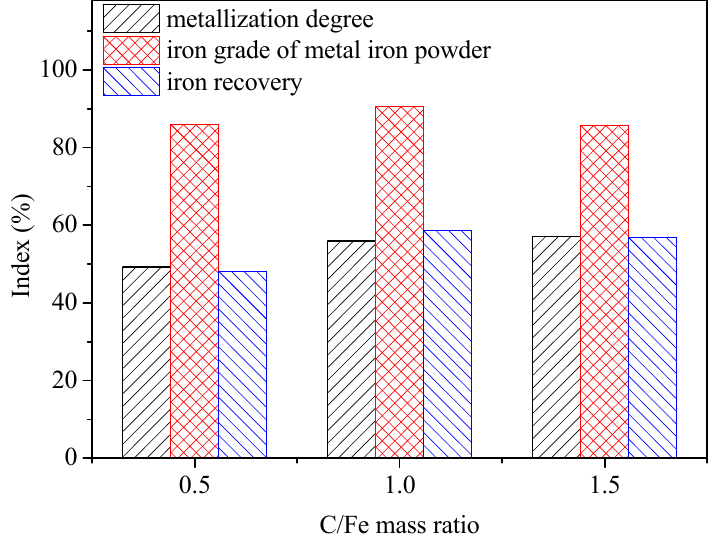
Figure 6. Effect of C/Fe mass ratio on the reduction and separation indexes (reducing at 1300 °C for 20 min).